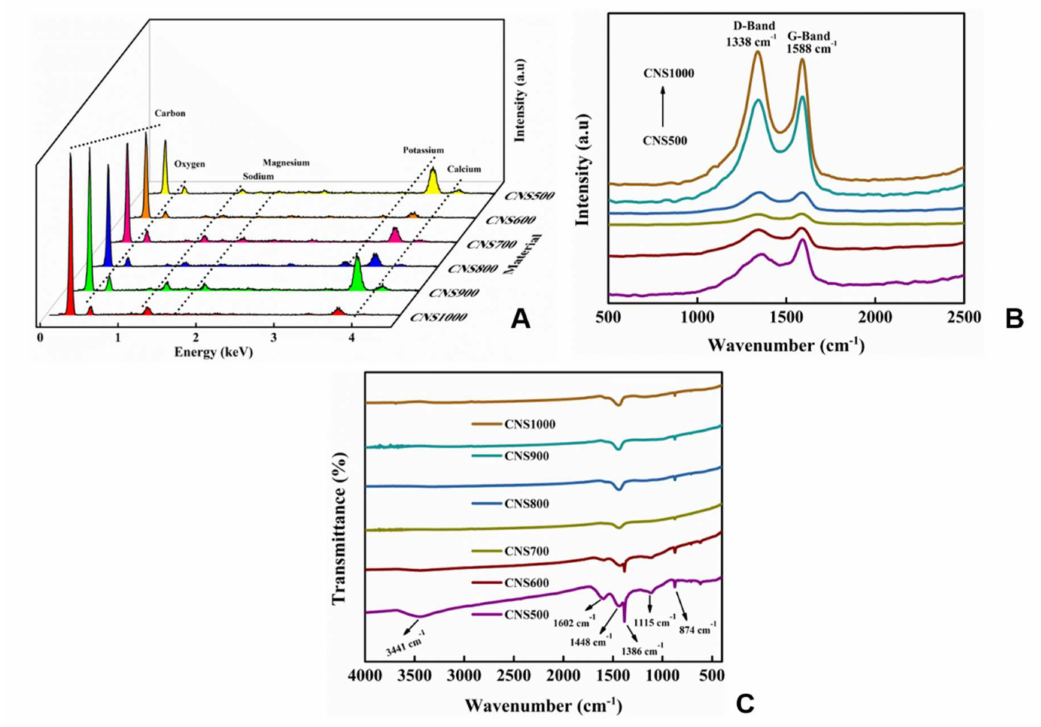
Figure 2. EDS spectra ( A ), Raman spectra ( B ), and FTIR spectra ( C ) of CNS500, CNS600, CNS700, CNS800, CNS900, and CNS1000